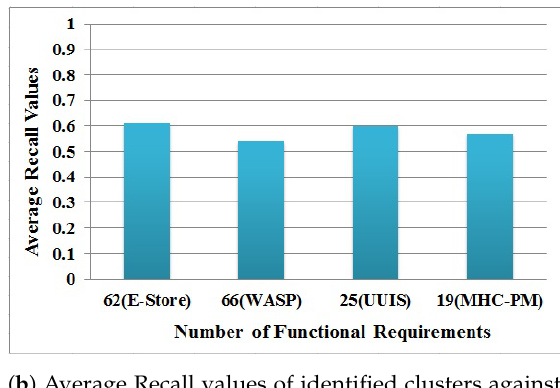
Figure 4. Average Precision and Recall of identified clusters against the number of